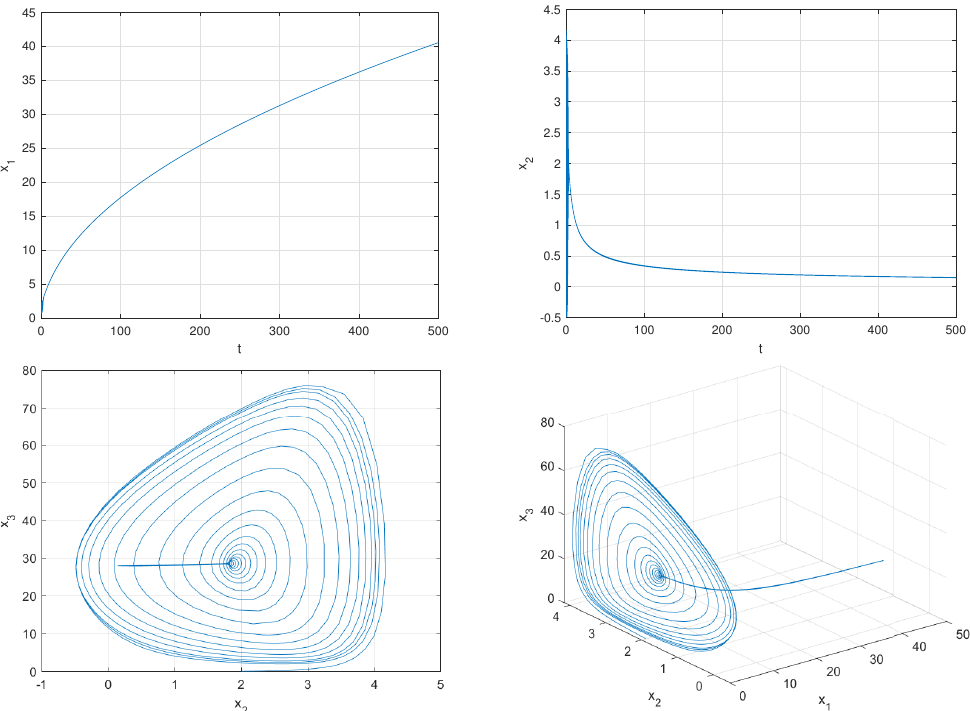
Figure 16. Chaos disappears for a = 10, b = 28 and d = 0.1 at c = 14.